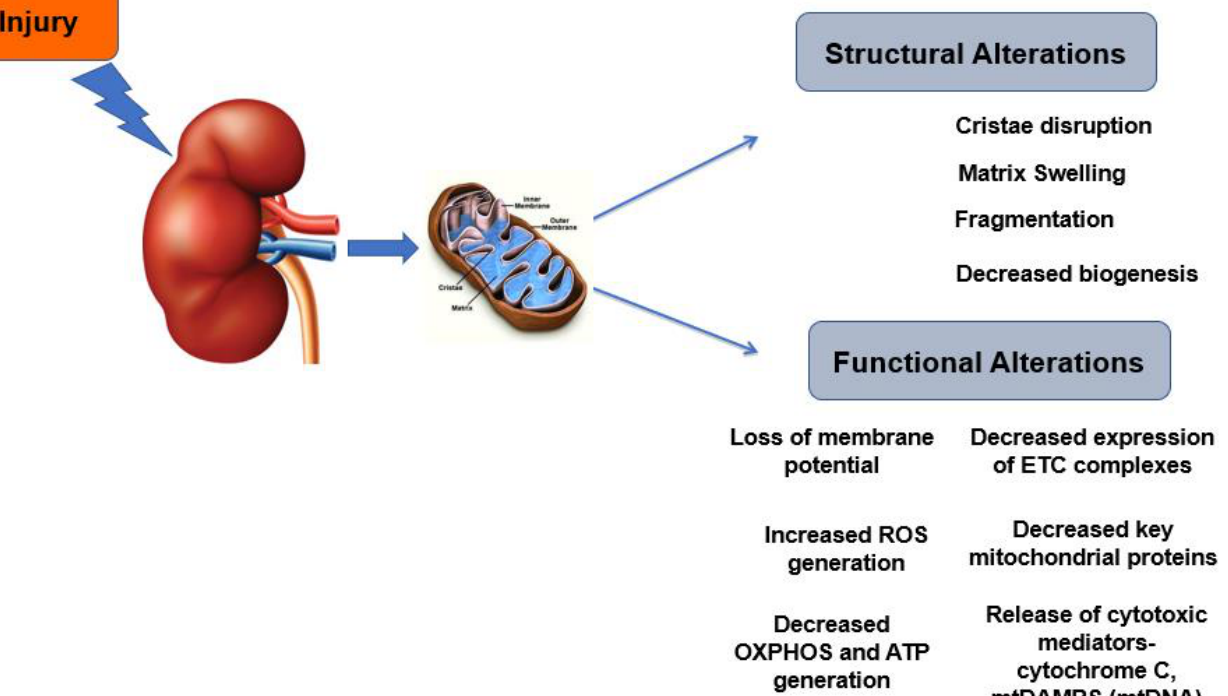
Figure 1. Mitochondrial structural and functional alterations in AKI.